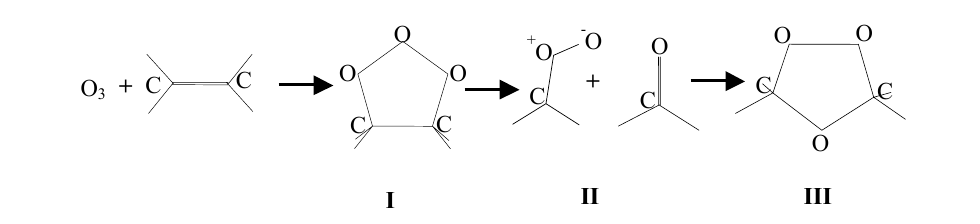
Fig. 1 Criegee mechanism of ozonization reaction of alkenes.